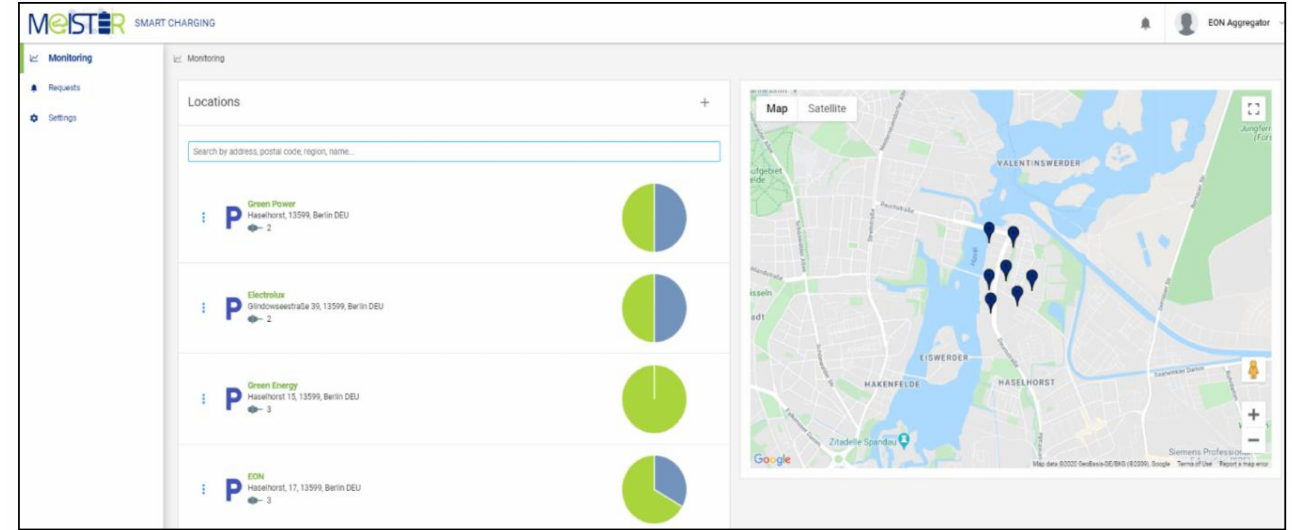
Figure 11. MEISTER